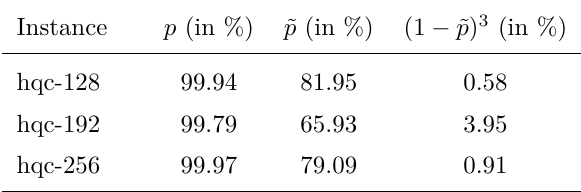
Table 3: The approximated probabilities p for successfully sampling a bit position in the range required for unbiased modulo reduction, ˜ p for completing the rejection sampling routine without exhausting the initially generated randomness, and for a message that causes at least 3 additional seedexpander